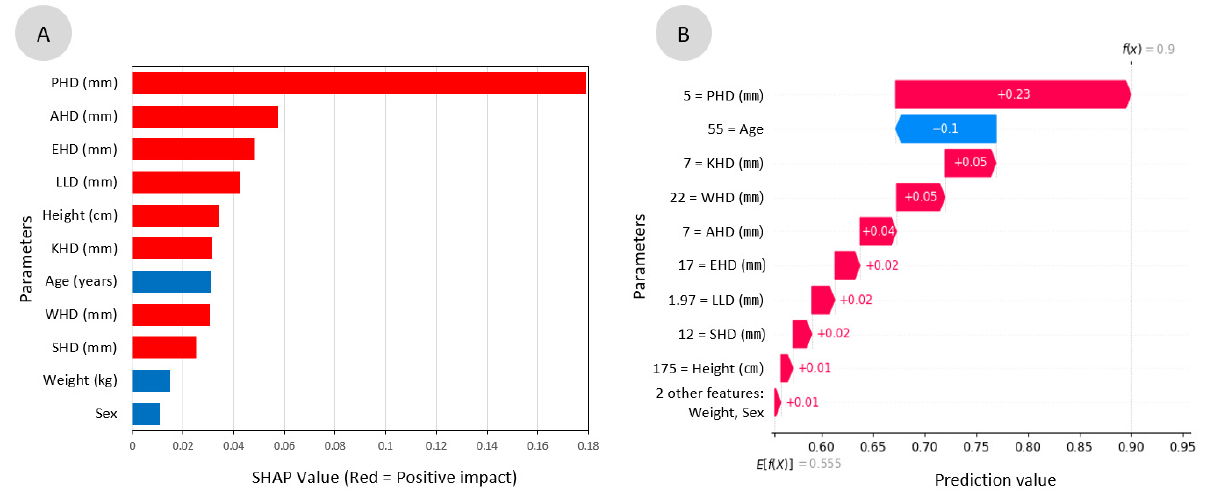
Figure 5. Feature analysis for the parameters using global interpretation. ( A ) Shapley additive explanation values for dominant parameters in the order of importance for all 140 participants. ( B ) Specific case analysis for the parameter of the 15th participant among 140 participants.